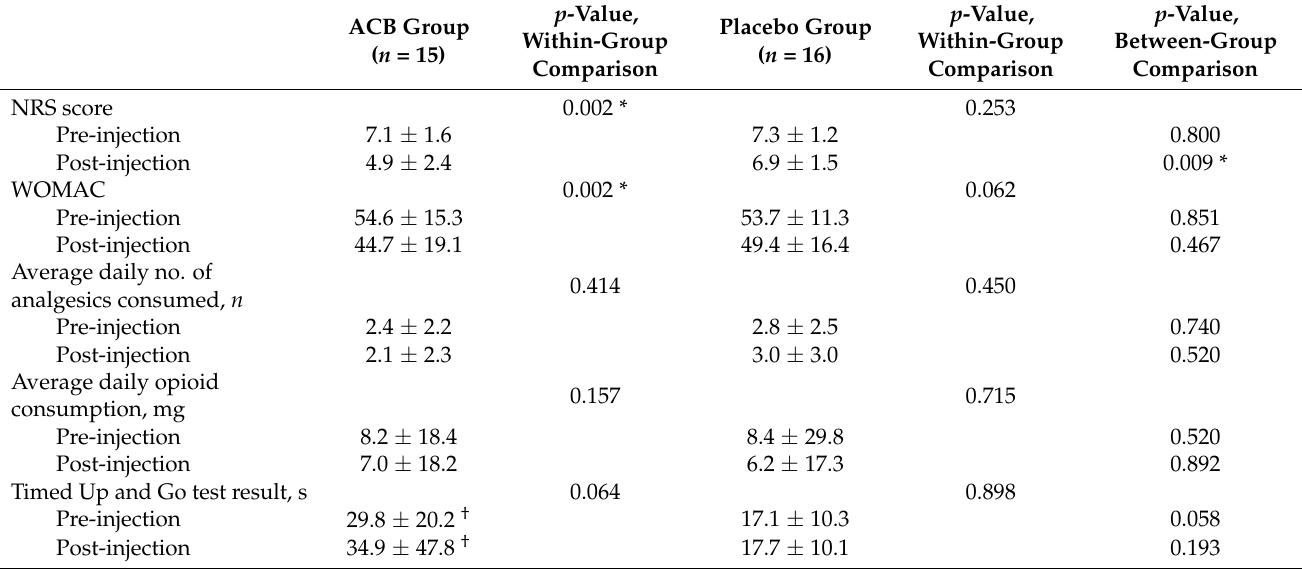
Table 2. Changes in the outcome measurements before and after injection.